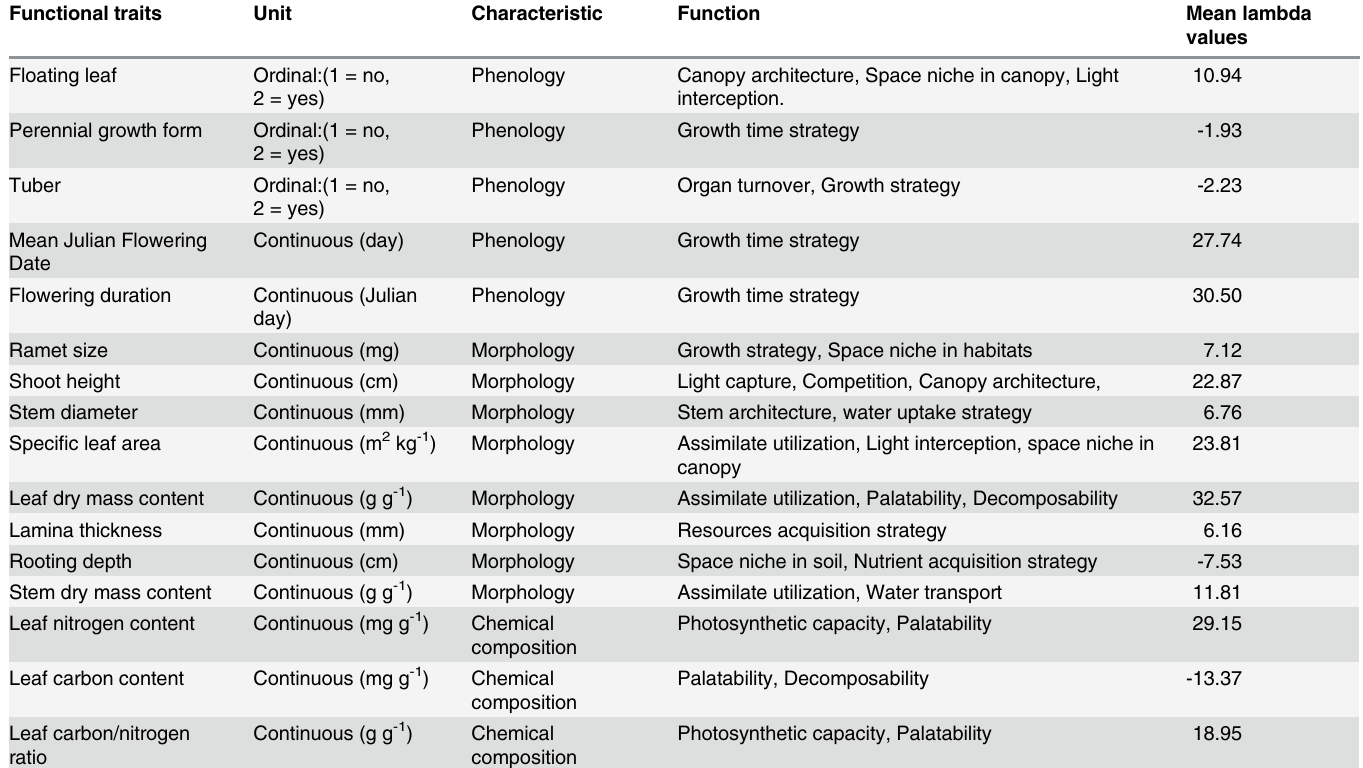
Table 2. List of 16 plant functional traits studied for 17 macrophyte species. The mean lambda values derived from the maxent models in which traits are standardised to unit variance. Functional